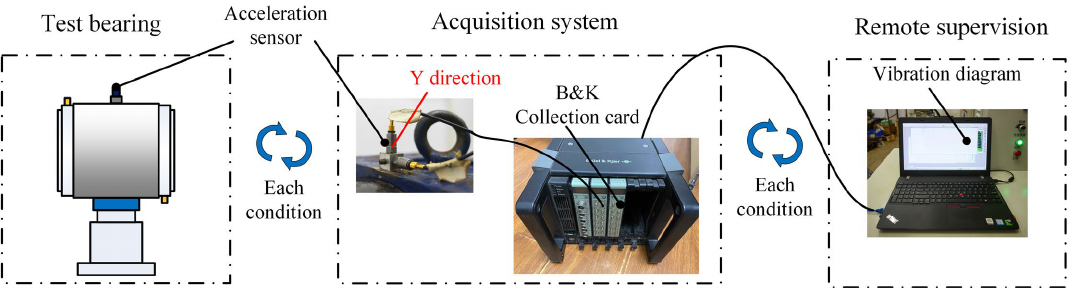
Figure 3. Friction-induced vibration acquisition system.